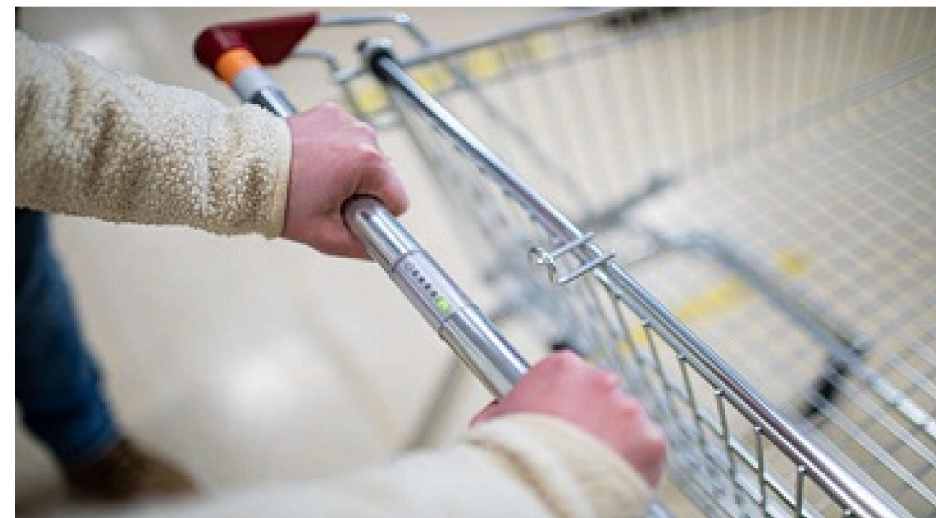
Figure 1. MyDiagnostick single lead ECG sensor embedded into the handles of supermarket trolleys to detect atrial fibrillation. A participant should place both hands around the device for 60 s. Depending on the detection of atrial fibrillation or not, the sensor will present with a red cross or a green tick, respectively.